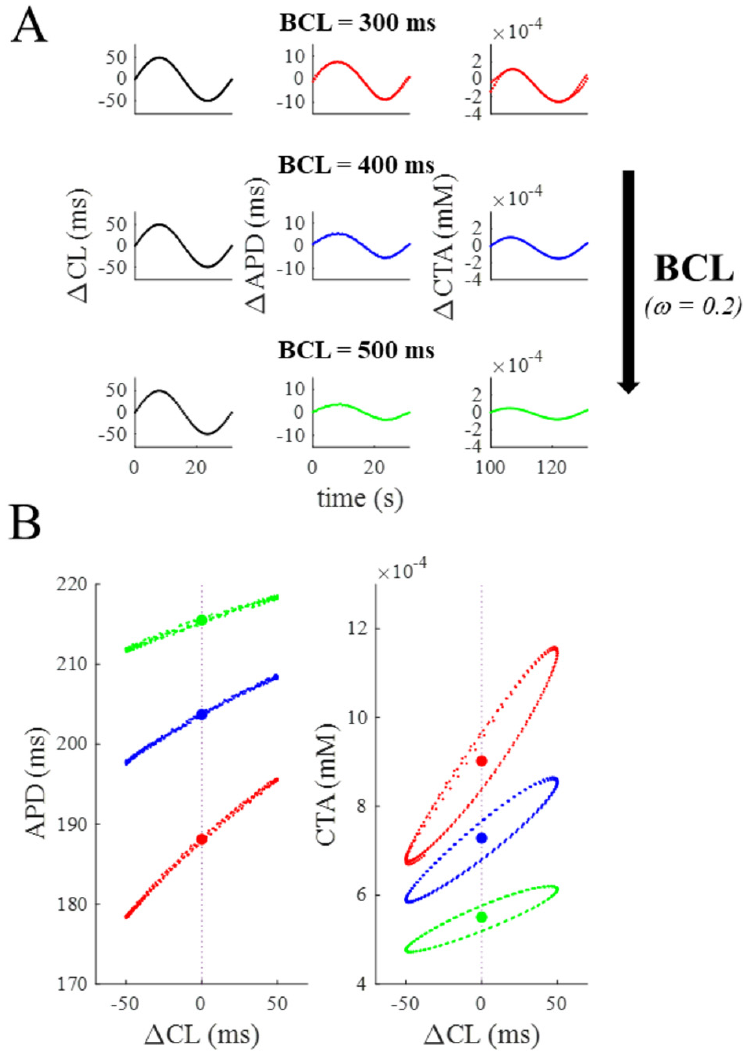
Figure 2. Dependence of APD and CTA oscillations from BCL . ( A ): When the OR model was paced according to Equation (1) with a low ω value and σ = 50 ms (first column), the amplitude of APD and CTA oscillations decreased with pacing frequency (1/BCL, values reported in figure) (black arrow). ( B ): btb-ER representations of the APD and CTA sequences of panel A with the same color code.